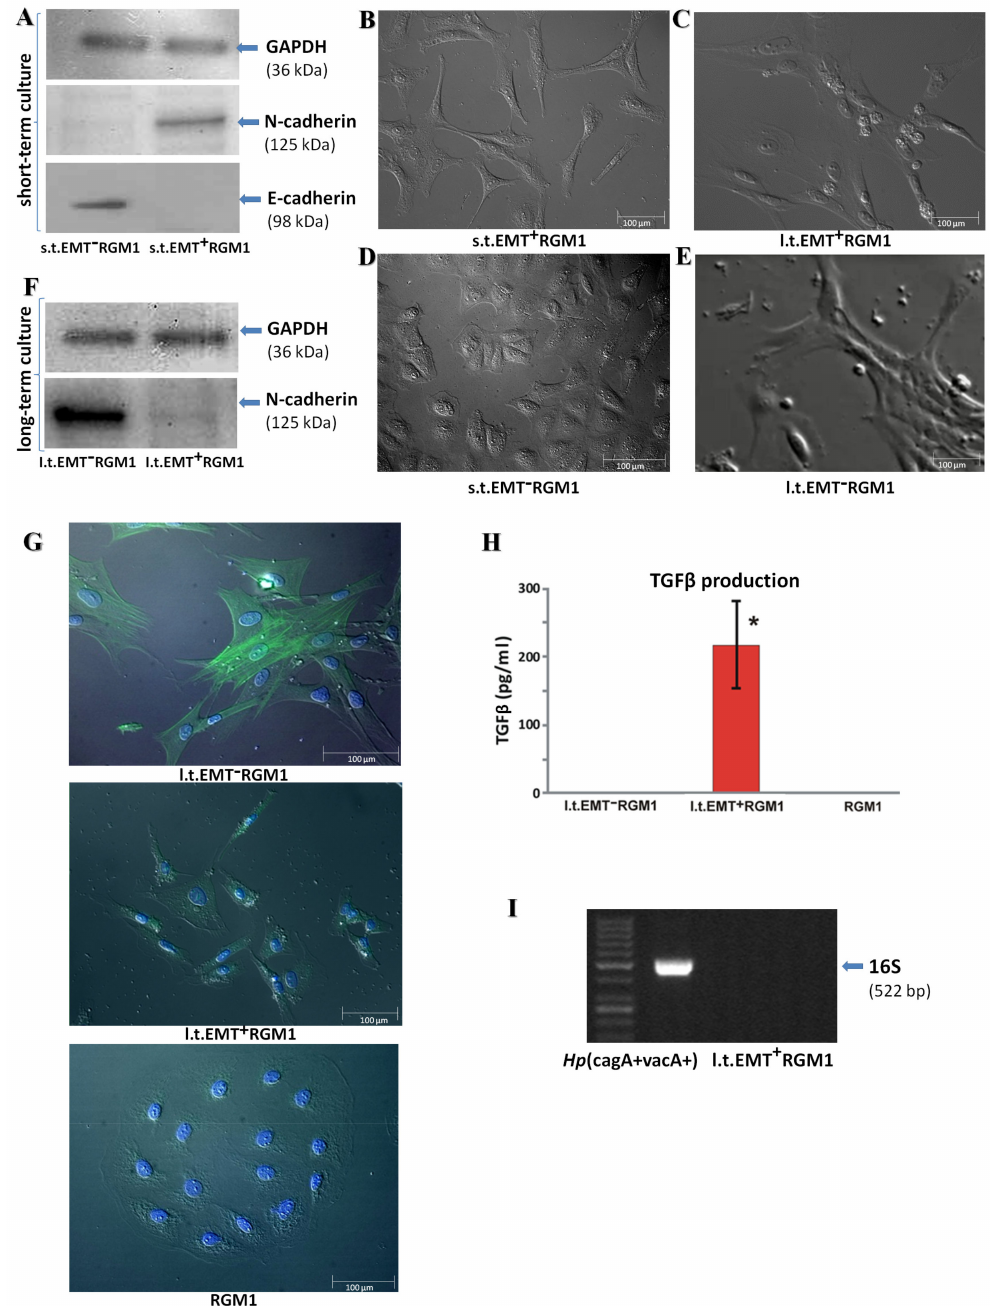
Figure 1. Long-term influence of Hp -AGF secretome induces phenotypical changes in pro-invasive EMT + RGM1 cells. ( A ) Short-term cell Western blot analysis. Western blot analysis of the EMT process indicators: E- and N-cadherin in total cellular proteins isolated from short-term (96 h) RGM1 cells culturedingastricfibroblast(GF)secretome(s.t.EMT − RGM1cells)andfromshort-term(96h)RGM1cells cultured in Hp -AGF secretome which successfully transmigrated through the Transwell microporous membranes towards Hp -AGF secretome during 24 h (s.t.EMT + RGM1 cells). The 10 µ g of total cellular proteins were loaded per each lane. ( B ) Nomarski contrast of s.t.EMT + RGM1; ( C ) l.t.EMT + RGM1; ( D ) s.t.EMT − RGM1; and ( E ) l.t.EMT − RGM1. ( F ) Long-term cell Western blot analysis. Western blot analysis of N-cadherin in total cellular proteins isolated from long-term (30 days) EMT − RGM1 cells cultured in GF secretome (l.t.EMT − RGM1 cells) and from long-term (30 days) EMT + RGM1 cells cultured in the secretome from Hp -AGFs (l.t.EMT + RGM1), suggesting their reprogramming. The 10 µ g of total cellular proteins were loaded per each lane. ( G ) Nomarski contrast and immunofluorescence of α